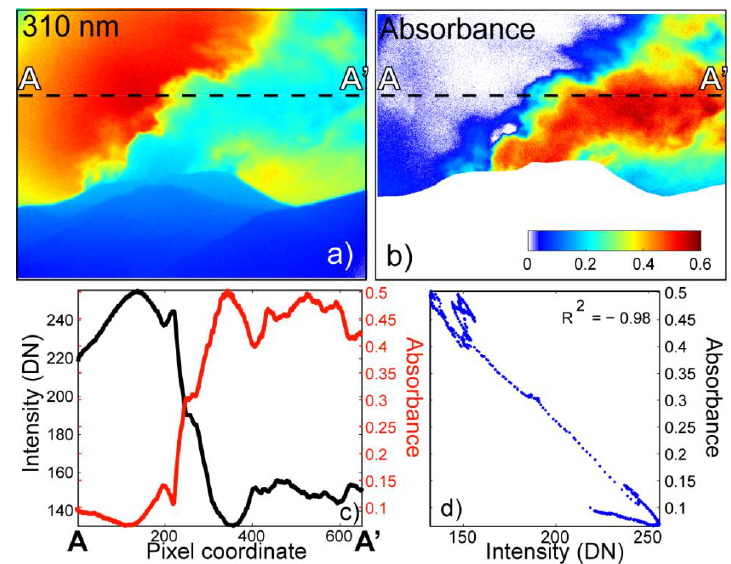
Figure 3. The image quality calculation method using the correlation coefficient between the 310 nm filter image ( a ) and the corresponding absorbance image ( b ). An intensity profile associated with a section (dashed line) crossing the volcanic plume, for both the 310-nm filter and absorbance images, is obtained ( c ). If these profiles are negatively correlated with a high correlation coefficient ( d ), then the gas is visible within the plume.